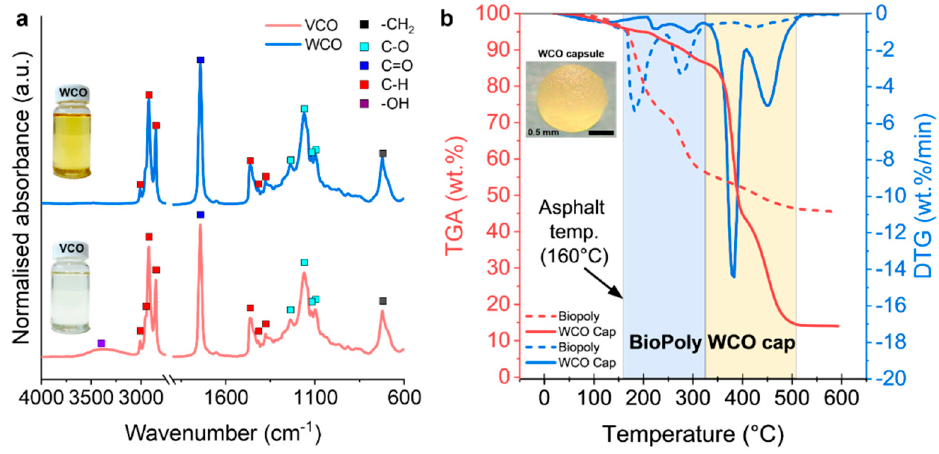
Figure 5. Results of chemical and thermal characterisation of rejuvenating agents (WCO versus VCO), WCO capsule and sodium-alginate biopolymer: ( a ) Normalised infrared spectra of waste and virgin cooking oil; and ( b ) TGA results of biopolymer (BioPoly) and WCO capsules (WCO Cap).